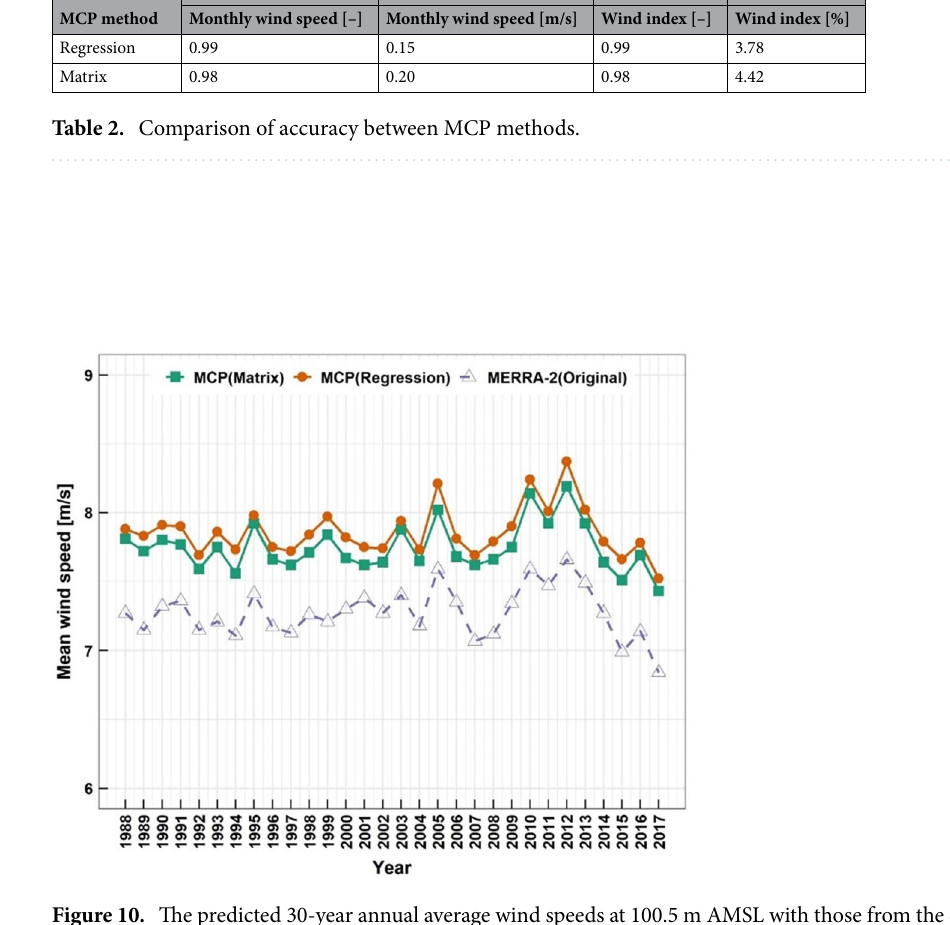
Figure 10. The predicted 30-year annual average wind speeds at 100.5 m AMSL with those from the original MERRA-2